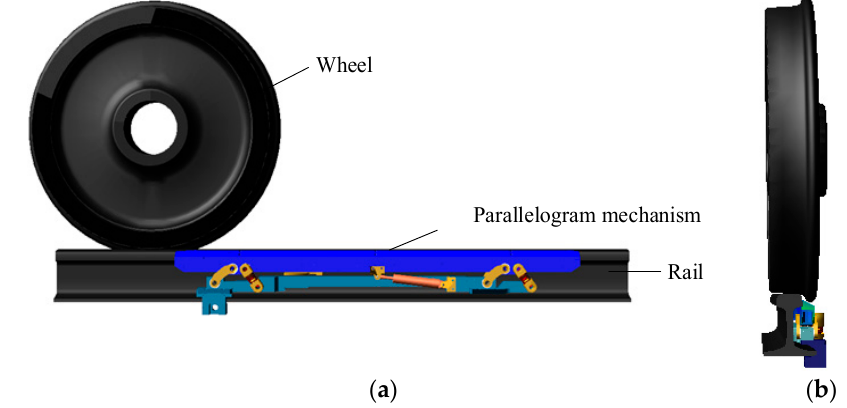
Figure 4. The dynamic simulation model: ( a ) The front view; ( b ) The side view.